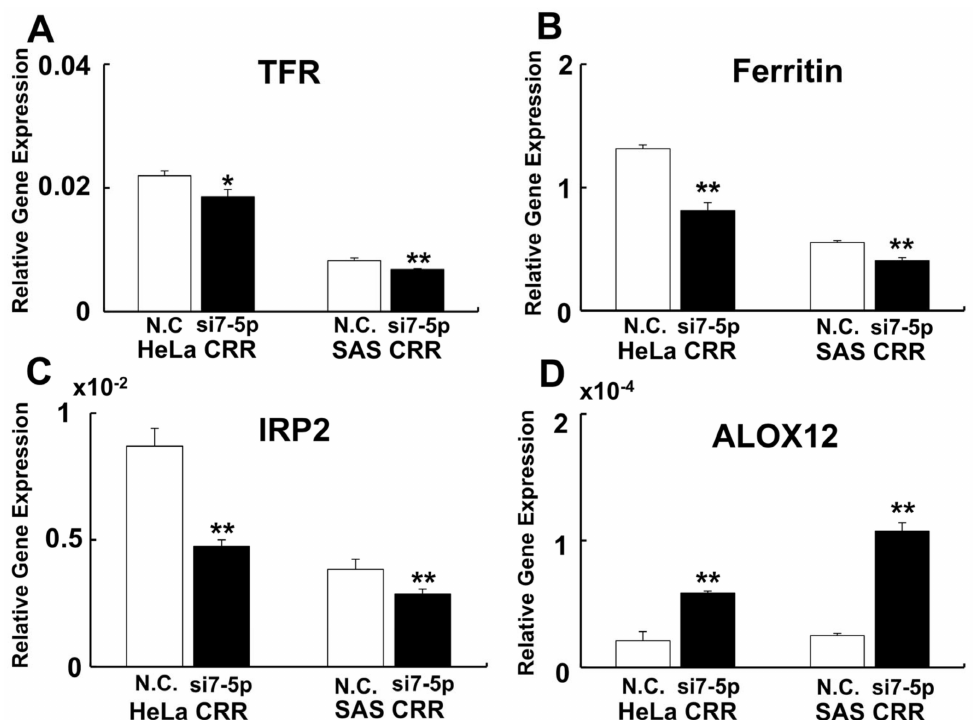
Figure 3. Knockdown of miR-7-5p enhances ferroptosis signaling. To investigate whether ferroptosis signaling was enhanced by knockdown of miR-7-5p, ferroptosis–related gene expressions were performed by qPCR. ( A ) TFR . ( B ) Ferritin . ( C ) IRP2 . ( D ) ALOX12 . MiR-7-5p down-regulate iron- related gene expression and down-regulation of ferritin leads to an increase in intracellular free iron. The expression of ALOX12 , which enhances ferroptosis, increased after the miR-7-5p knockdown. *: p < 0.05, **: p < 0.01 using Student’s t test. Each qPCR was performed 3